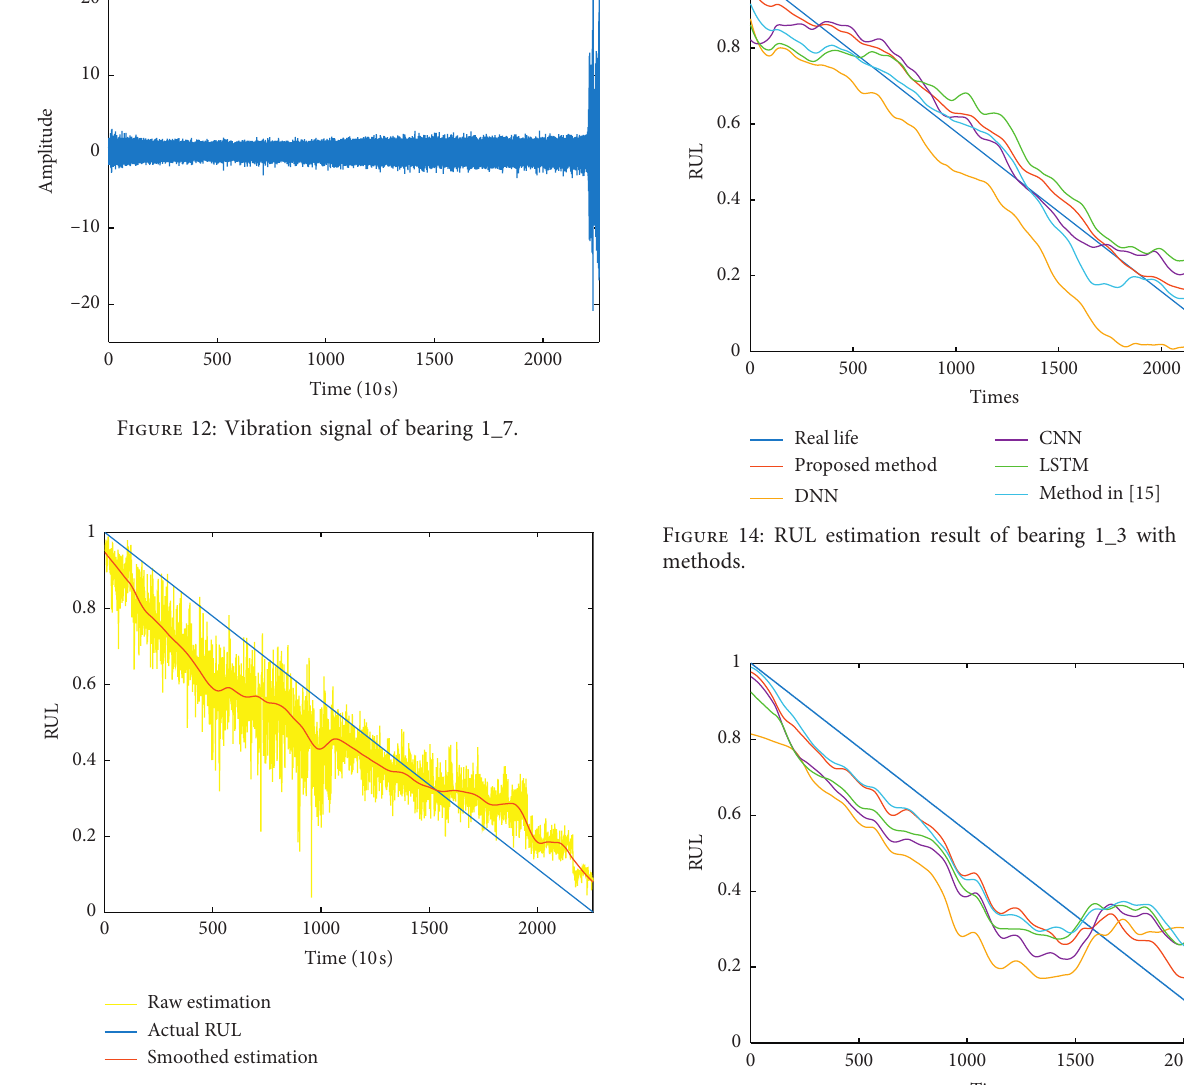
Figure 13: RUL estimation result of bearing